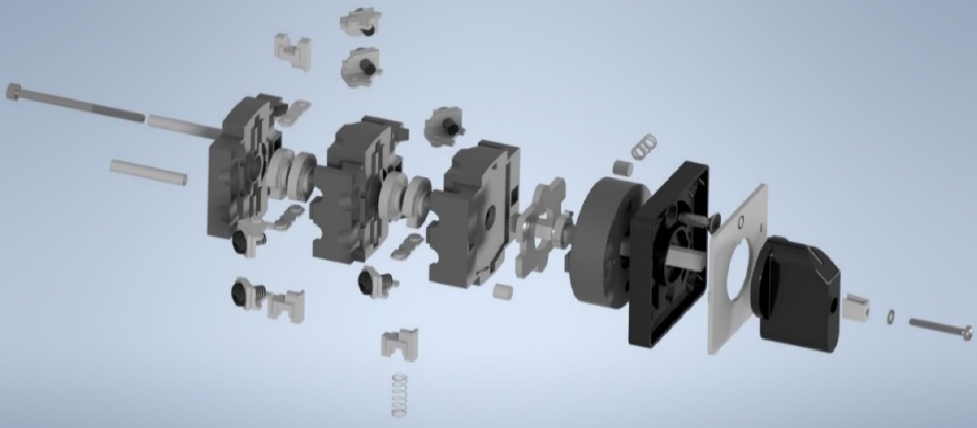
Figure 5. An exploded view of a cam switch digital twin used in the assisted assembly process for implementation into mixed reality devices.